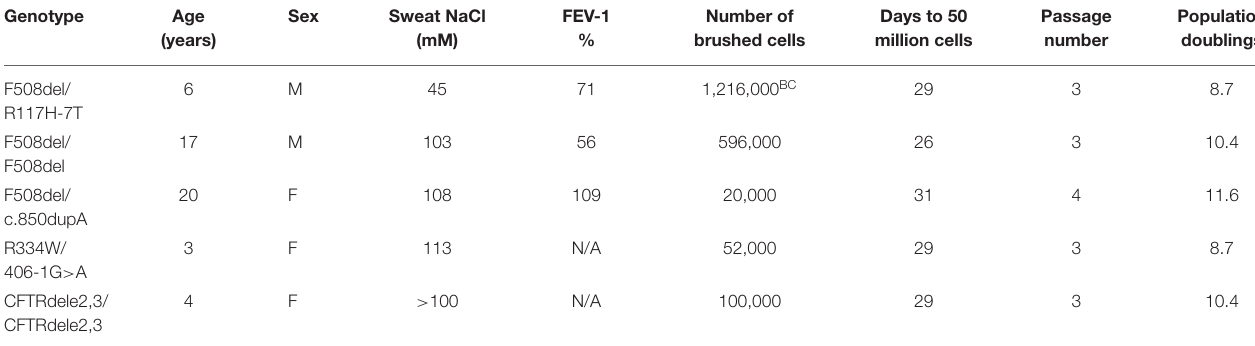
TABLE 1 | Clinical characteristics of CF nasal cell donors and expansion of CF nasal cells by EpiX TM technology.